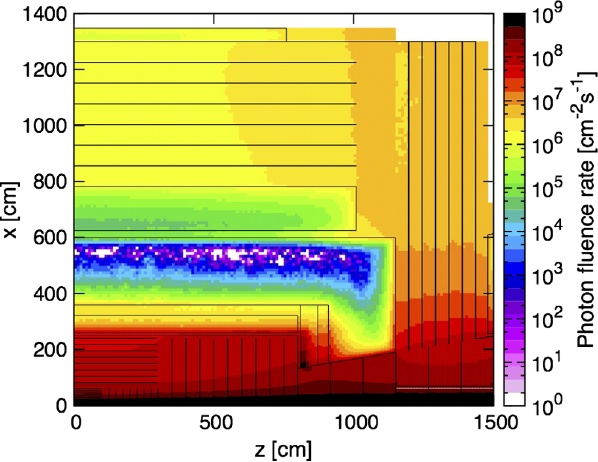
FIG. 8. Photon fluence rate for an instantaneous luminosity of 30 × 10 34 cm − 2 s − 1 : top view, zoom on barrel and endcap muon chambers. The same scoring resolution as the one of Fig. 5 has been adopted, apart from the central region ( R < 2 . 5 m and j z j < 8 m), where the considered radial resolution is 0.5 cm, instead of 1 cm.